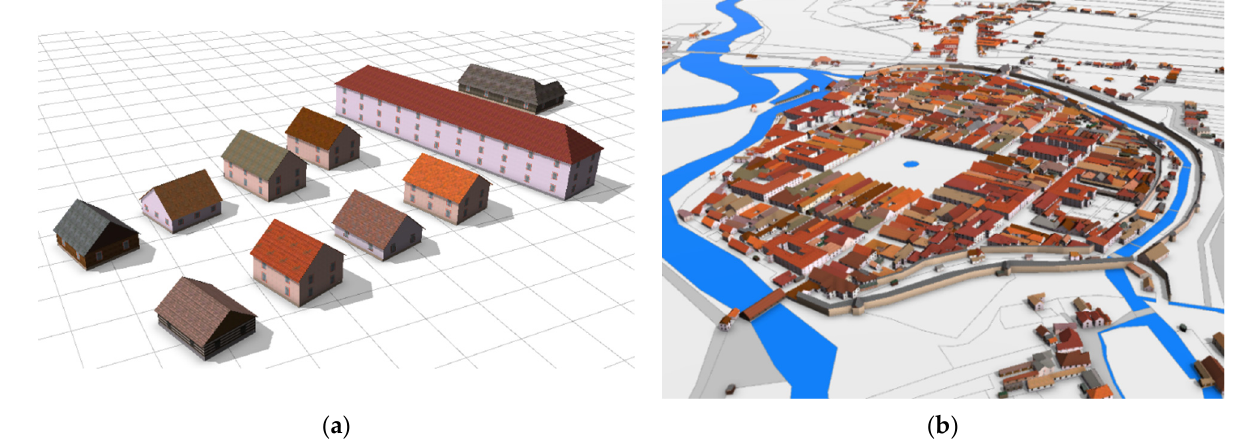
Figure 6. Example of procedurally modelled buildings: ( a ) testing scene for debugging the rule file; ( b ) buildings and city walls of ˇCesk é Budˇejovice, which were procedurally modelled based on vectorisations of the Imperial Obligatory Imprints of the Stable Cadastre 1:2880